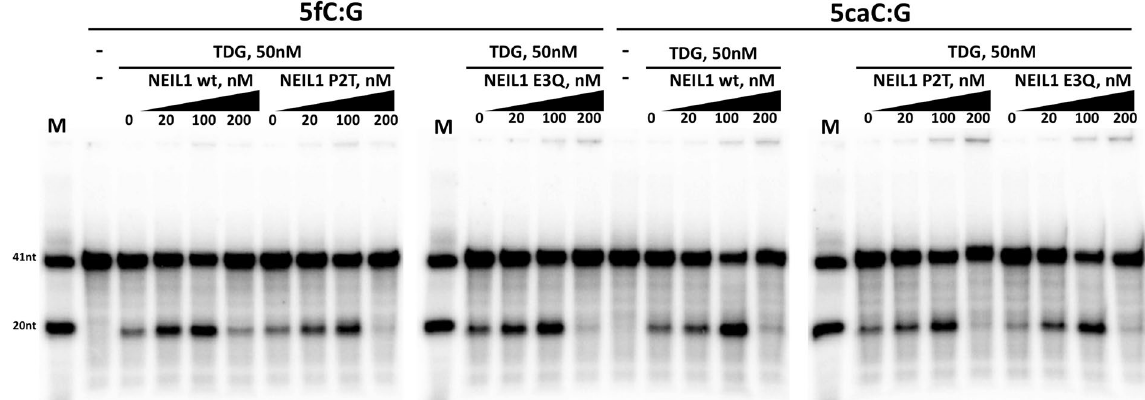
Figure 7. NEIL1 stimulates 5fC and 5caC excision by TDG: 50 nM TDG and varying amounts of NEIL1 or the control P2T variant were incubated (37 °C, 60 min) with 20 nM dsDNA containing a radiolabelled strand with a T base in a T/G mismatch. DNA was then broken at AP-sites in alkaline conditions and analysed by denaturing gel electrophoresis and autoradiography. NEIL1 mediated stimulation of the TDG 5fC and 5caC excision activities does not depend on the NEIL1 catalytic activities.